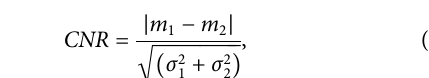
FIGURE 10 | DAR results of different energy bin